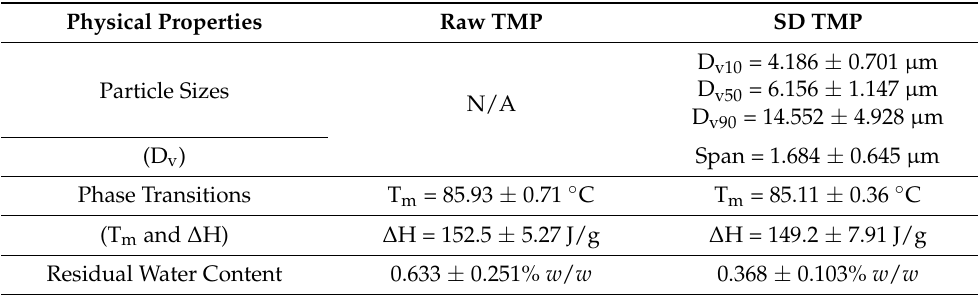
Table 2. Physical properties of raw TMP and spray dried (SD) TMP. ( n = 3, Mean ± SD).